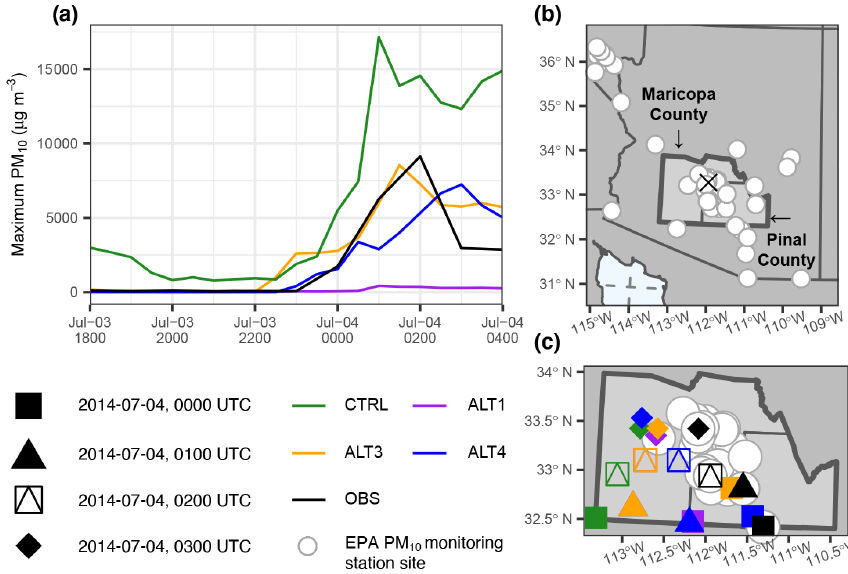
Figure 13. (a) Time series of observed (OBS) and simulated (CTRL, ALT1, ALT3, and ALT4) maximum PM 10 concentration (µgm − 3 ) for the combined Maricopa and Pinal counties in Arizona. Panel (b) highlights how most EPA monitoring stations in Arizona are in Maricopa county and Pinal county, clustered around the Phoenix metropolitan area (marked by the black × ). We used the hourly maximum PM 10 concentrations from the combined Maricopa and Pinal county areas for our assessment due to the shifted nature of the main dust-producing outflow boundary recorded by the EPA stations situated around Phoenix, Arizona, in the simulations. The map zoom in (c) of the Maricopa county and Pinal county boundaries shows the EPA station locations relative to the hourly PM 10 maximum values sampled for each test configuration and the observations on 4 July 2014 from 00:00–03:00UTC. The ALT2 configuration results are not included in this figure since they are nearly identical to results from the ALT1 configuration. Note that the CTRL, ALT1, and ALT3 PM 10 maximum value sites overlap on 4 July 2014 at 01:00UTC, and the ALT1 and ALT3 sites are co-located on 4 July 2014 at